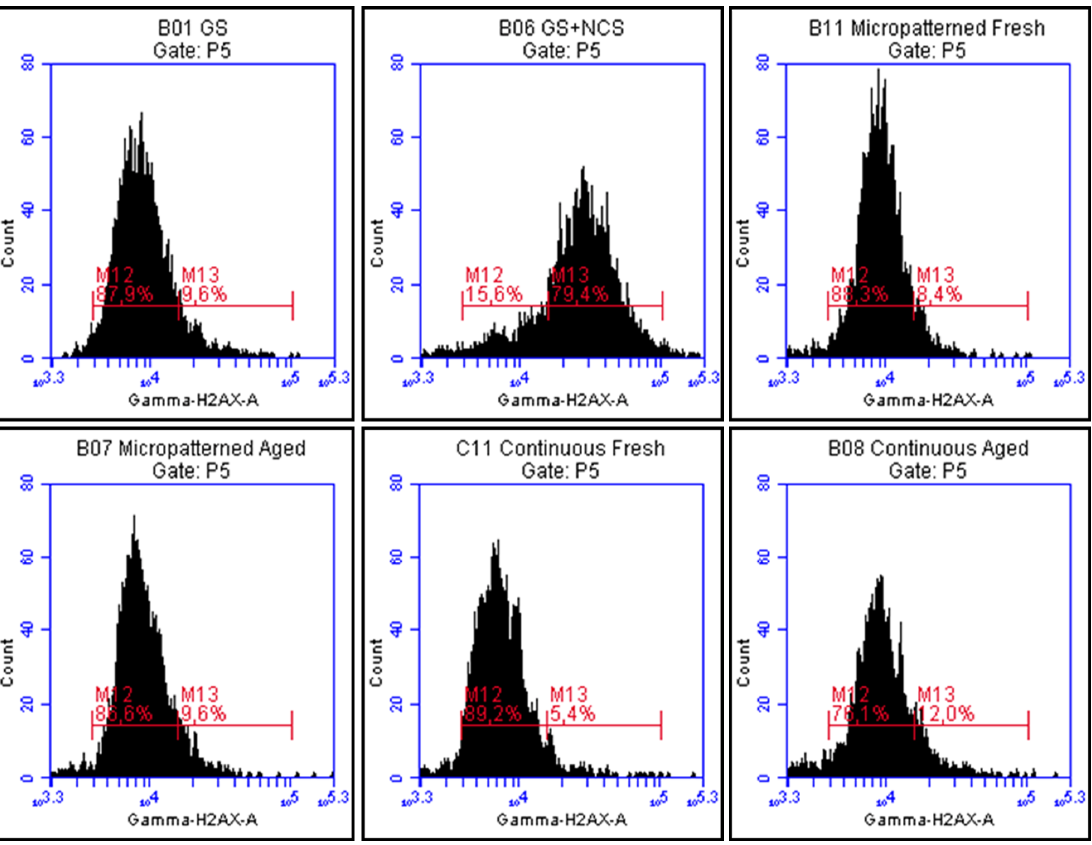
Figure 12. Flow cytometry of a marker of DNA damage response: gamma-H2AX in human osteoblast-like U-2 OS cells on micropatterned or continuous fresh and aged fullerene films after seven days of cultivation. GS, microscopic glass coverslips, reference material; GS + NCS, positive control to phosphorylation of histone H2AX (gamma-H2AX), induced by 1 h incubation of U-2 OS cells in neocarzinostatin (NCS; 700 ng/mL). M12 defines the percentage of cells with no increase of DNA damage (obtained from cells growing on reference material, GS); M13 defines the percentage of cells with increased DNA damage response represented by enhanced phosphorylation of histone H2AX (obtained from cells incubated with